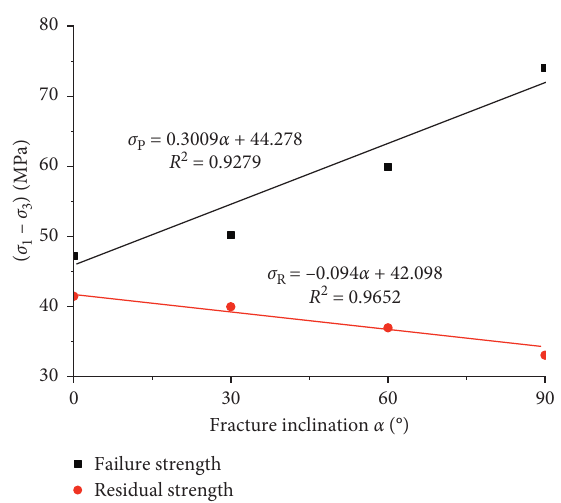
Figure 8: Relationship between strength and fissure inclinations under type I and II tests.